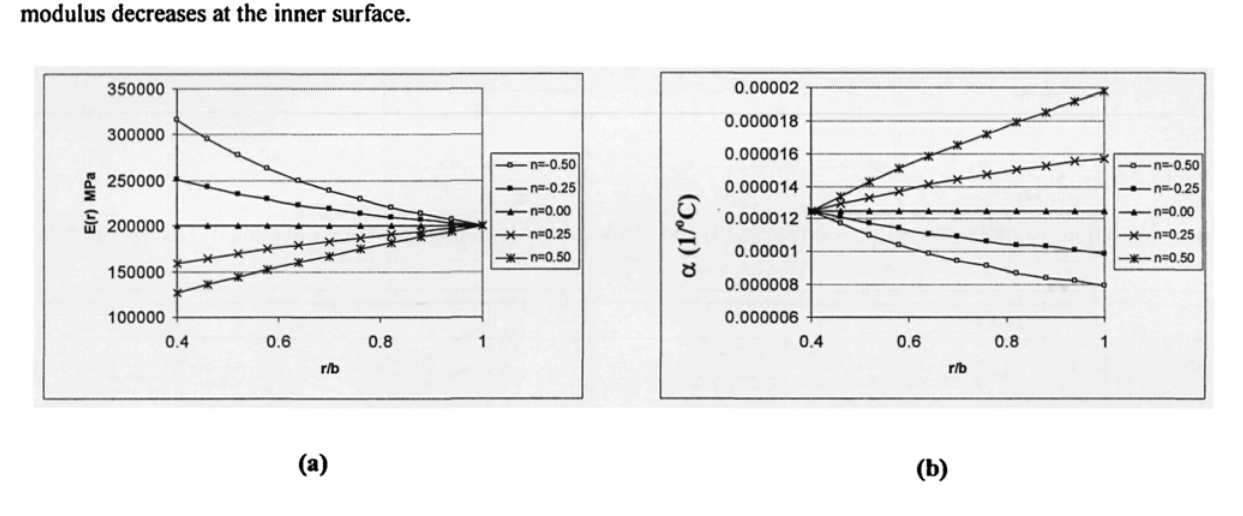
Fig. 2: Variations of elasticity modulus (a) and thermal expansion coefficient (b) along the radial direction of